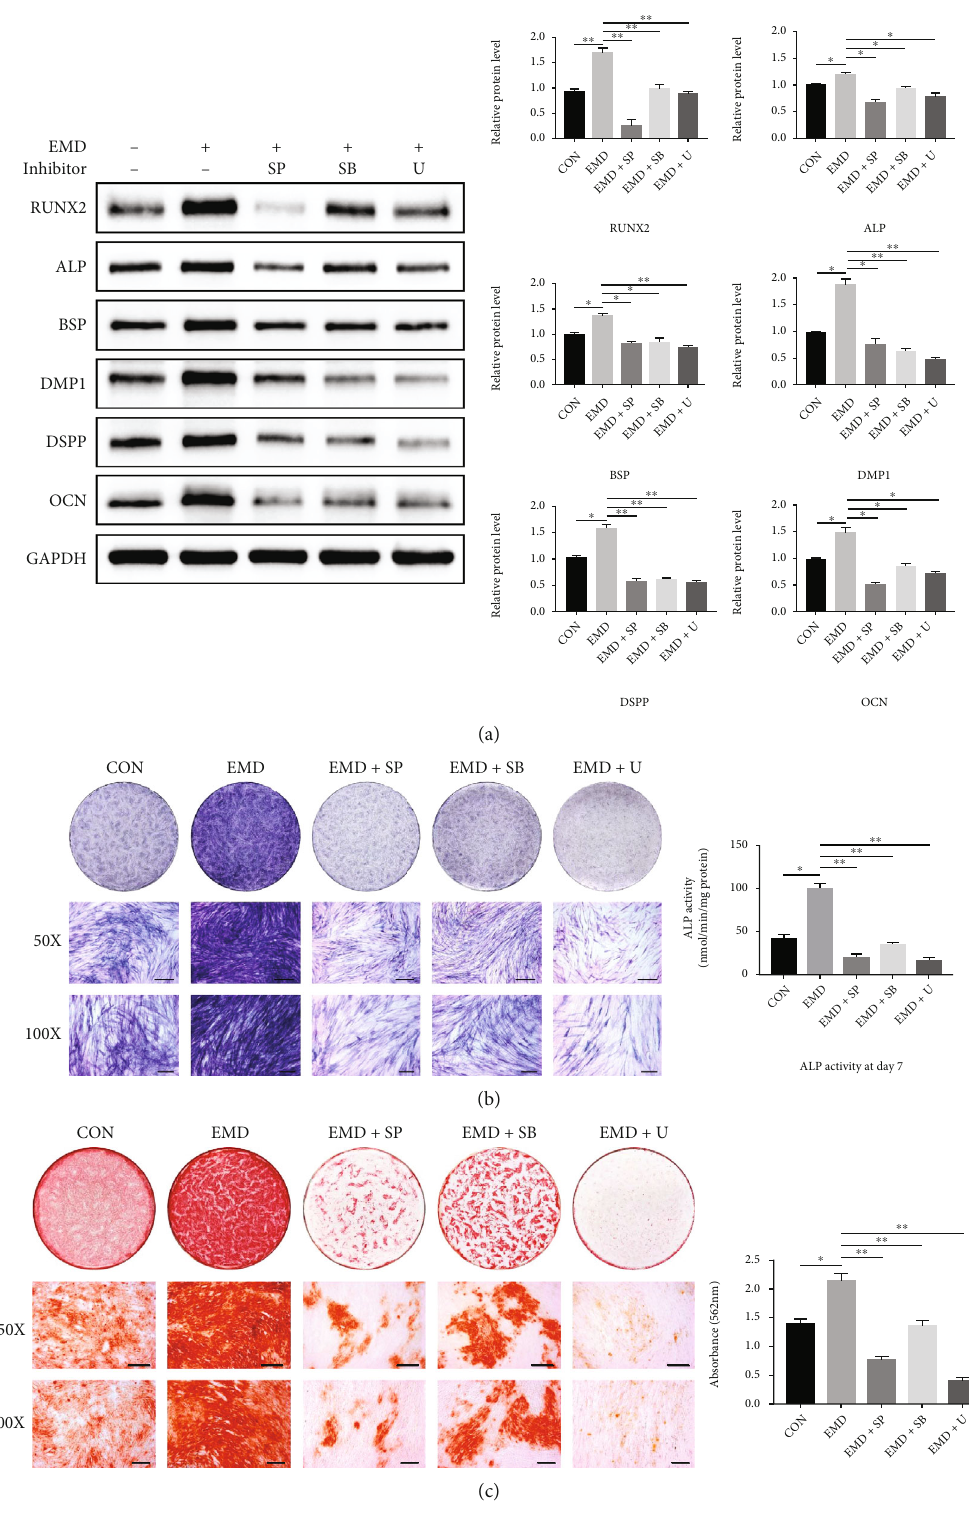
Figure 7: Blocking the MAPK signaling pathways inhibited odontoblastic di ff erentiation of EMD-treated DPSCs. Cells were divided into fi ve group: EMD, EMD+SP600125, EMD+SB203580, EMD+U0126, and a control group which cultured in OM alone. (a) Protein levels of RUNX2, ALP, BSP, DMP1, DSPP, and OCN were measured by western blot analysis at day 7. Quanti fi cation was done by Image Lab ™ software. (b) ALP staining and ALP activity assay at day 7. (c) Alizarin red staining and quanti fi cation at day 14. All data are presented as means ± SD of three independent experiments ( n =3). ∗ P < 0 : 05 , ∗∗ P < 0 : 01